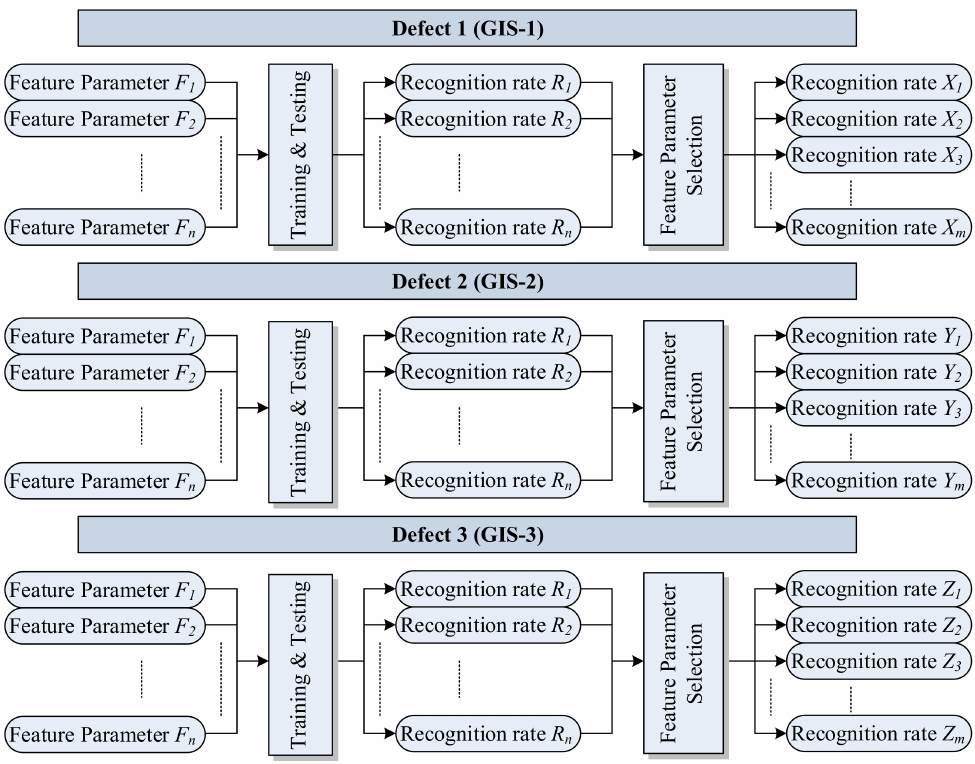
Figure 5. Selection of features for specific defects.